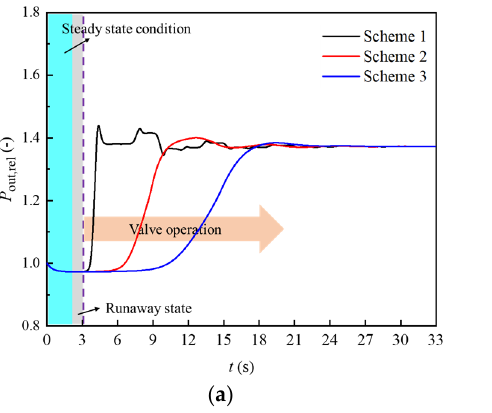
Figure 17. Variation law of return water pressure under different valve closing schemes. ( a ) 0.85 Q BEP . ( b ) 1.1 Q BEP . ( b ) 1.1 Q BEP